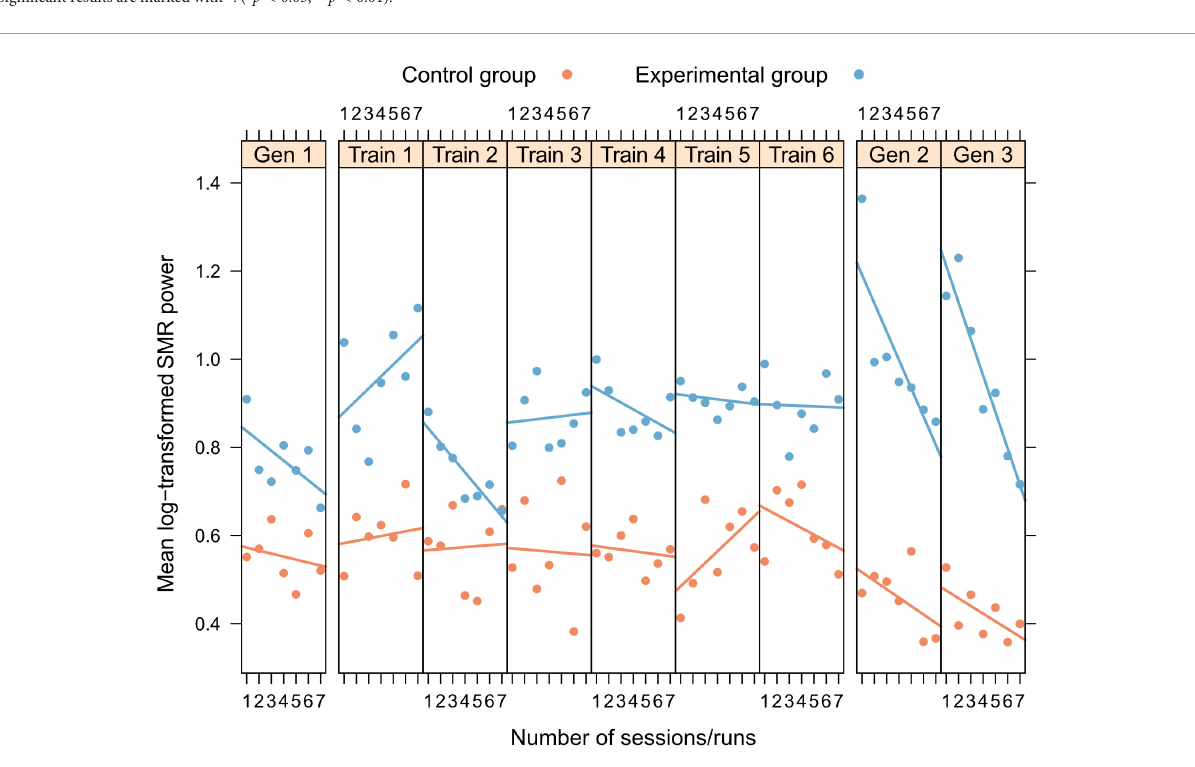
FIGURE3 Within- and between-session changes in log-transformed SMR power for training and generalization sessions, separately presented for experimental (blue) and control group